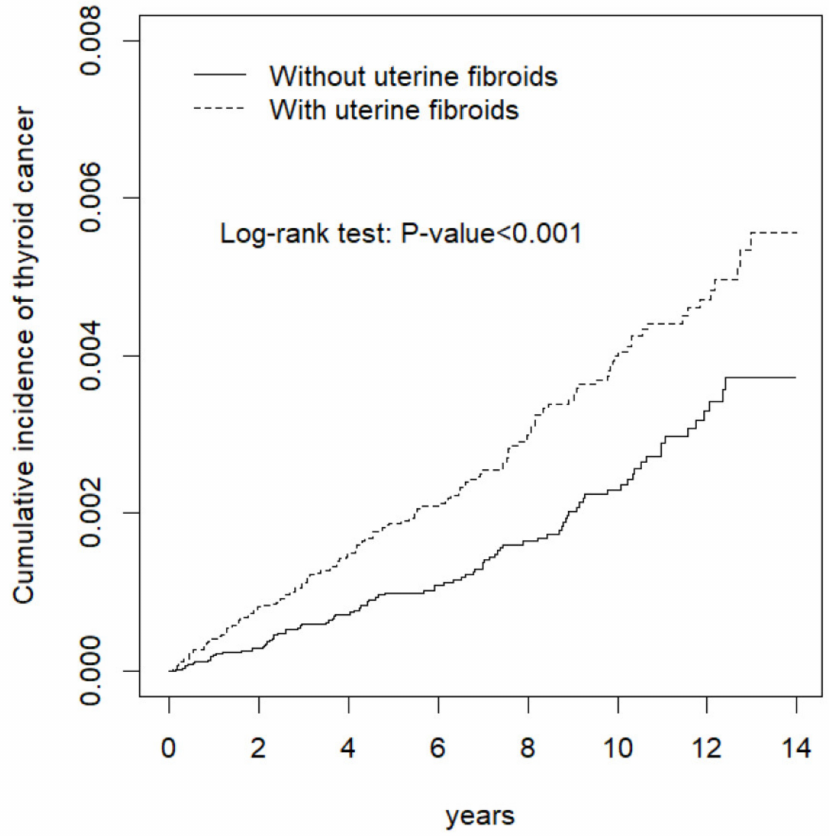
Figure 1. Cumulative incidence of thyroid cancer between women with and without uterine